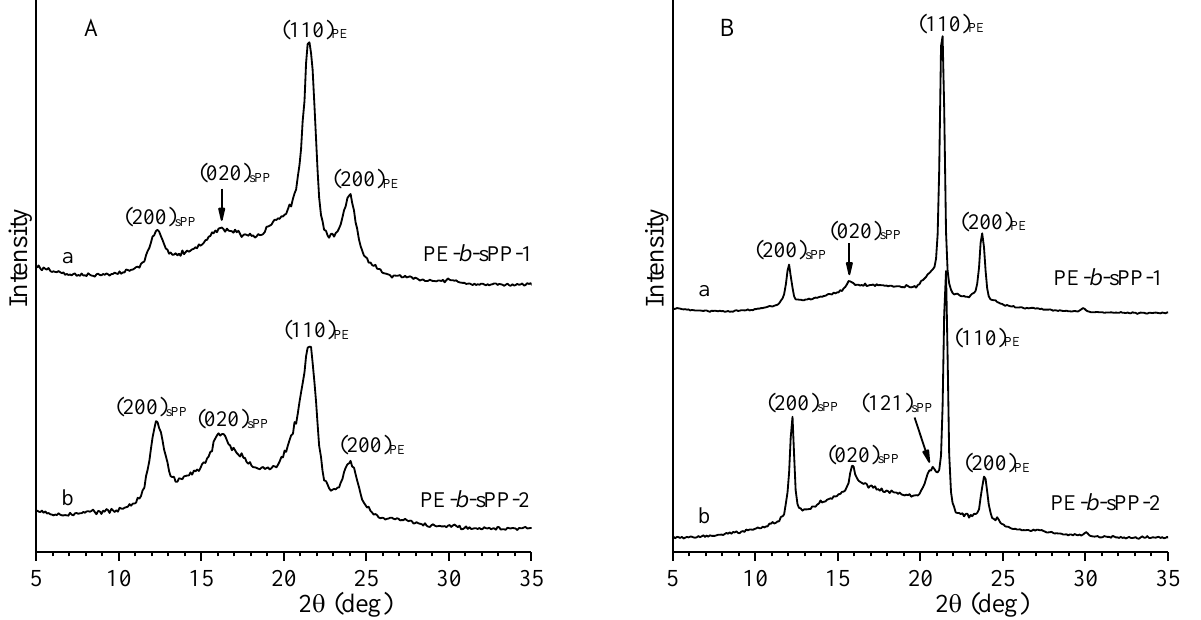
Figure 1. X-ray powder diffraction profiles of as-prepared samples ( A ) and of samples crystallized from the melt by compression molding and cooling down to room temperature at 10 ◦ C/min ( B ) of the BCP samples PE-b-sPP-1 (a) with f sPP = 53% and PE-b-sPP-2 (b) with f sPP = 75%. The (200) sPP , (020) sPP and (121) sPP reflections of form I of sPP at 2 θ = 12.2 ◦ , 16 ◦ , and 21 ◦ , and the (110) PE and (200) PE reflections at 2 θ = 21.5 ◦ and 24 ◦ of the orthorhombic form of PE are